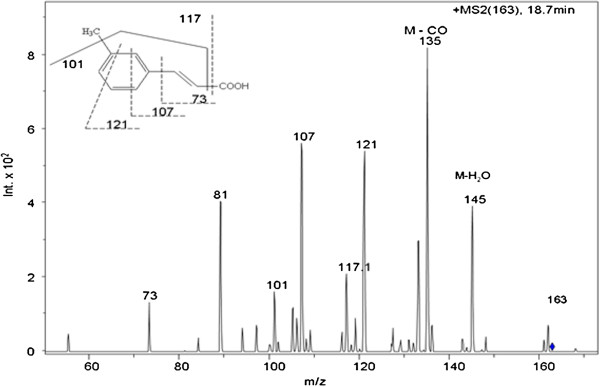
Tandem MS/MS analysis of an intermediate with a mass of 163 Daltons (intermediate #10 as indicated in Figure9and Table2).